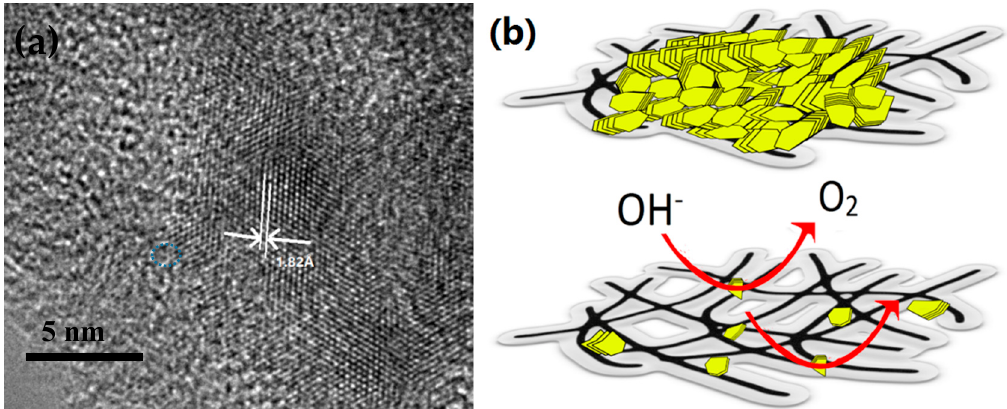
Figure 6. TEM images of MoS 2 @CNT: ( a ) high magnification image of MoS 2 @CNT and 1.82 Å is referred to the 2H-MoS 2 (105) plane [34]. ( b ) Schematic illustration of: top, pristine MoS 2 @CNT and bottom, etching MoS 2 @CNT OER process. Black network refers to CNT film and yellow sheets refer to MoS 2 .